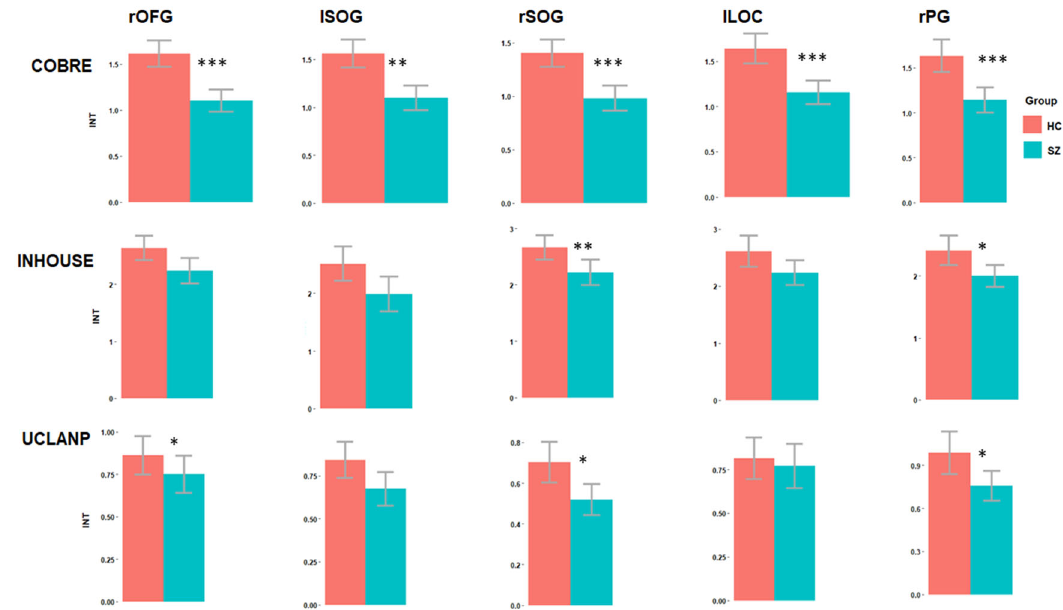
Fig. 3 Group differences in intrinsic neural timescales (INT) per sample and cluster, after FD outlier elimination. Bonferroni-corrected signi fi cant differences are marked. Red colour represents HC, while blue represents SZ. The asterisk indicates a P < 0.05 signi fi cance